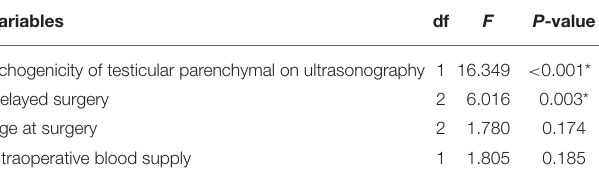
TABLE 3 | Multivariate analysis of variance of testicular volume